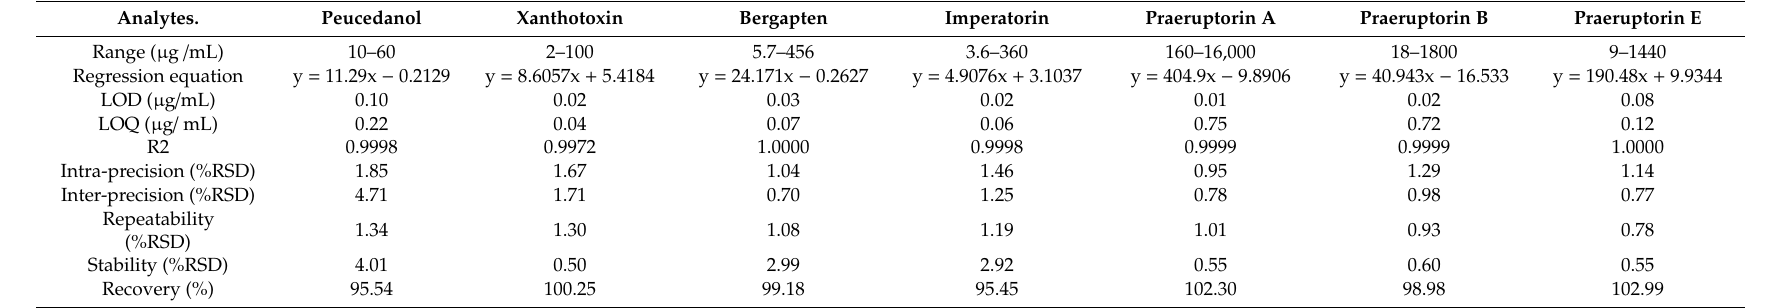
Table 4. Method validation of the detected